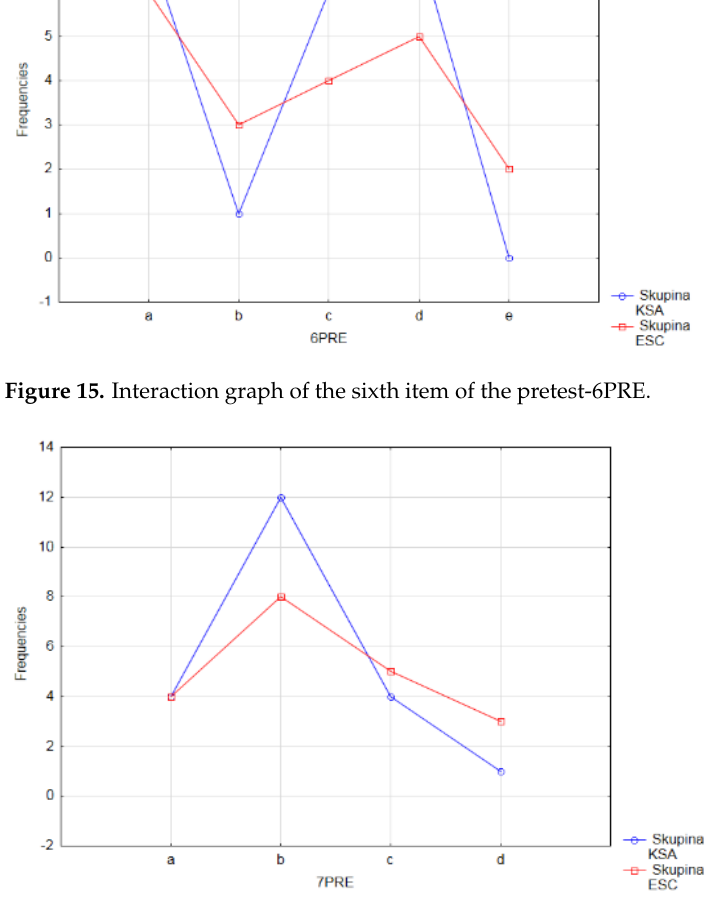
Figure 16. Interaction graph of the seventh item of the pretest - 7PRE.